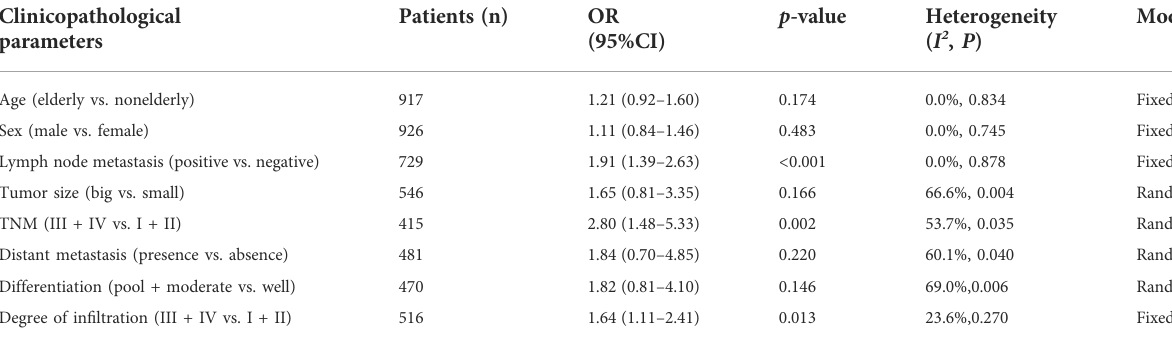
TABLE 3 Association of LINC00958 expression with clinicopathological